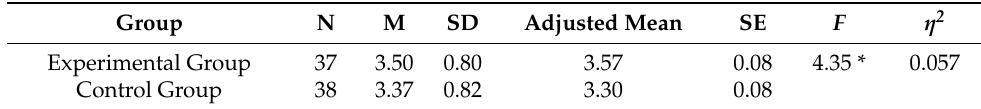
Table 2. The ANCOVA analysis data of learning motivation.